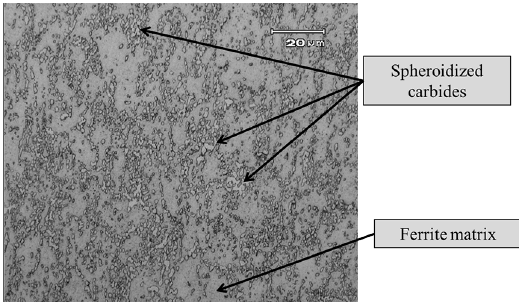
The worn volume was obtained according to the ASTM G133 - 05 (2010) standard 16 , section 9.3. Track